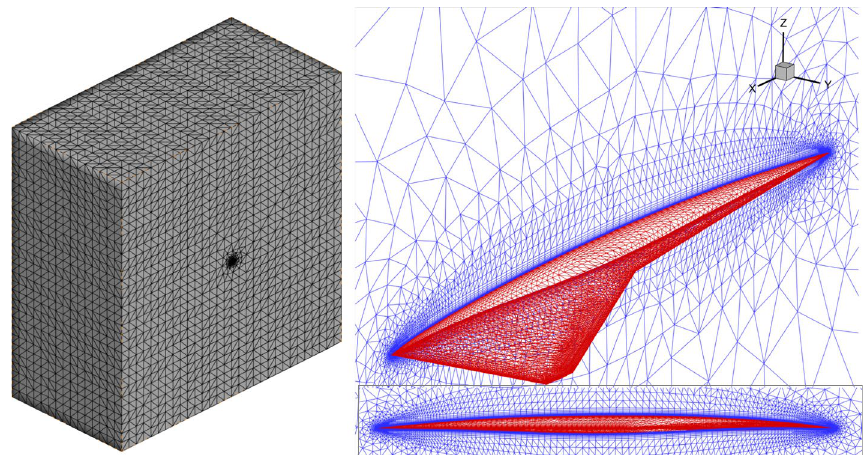
Fig. 13 Sketch of the computational mesh for the Sanger aerospace plane carrier wing